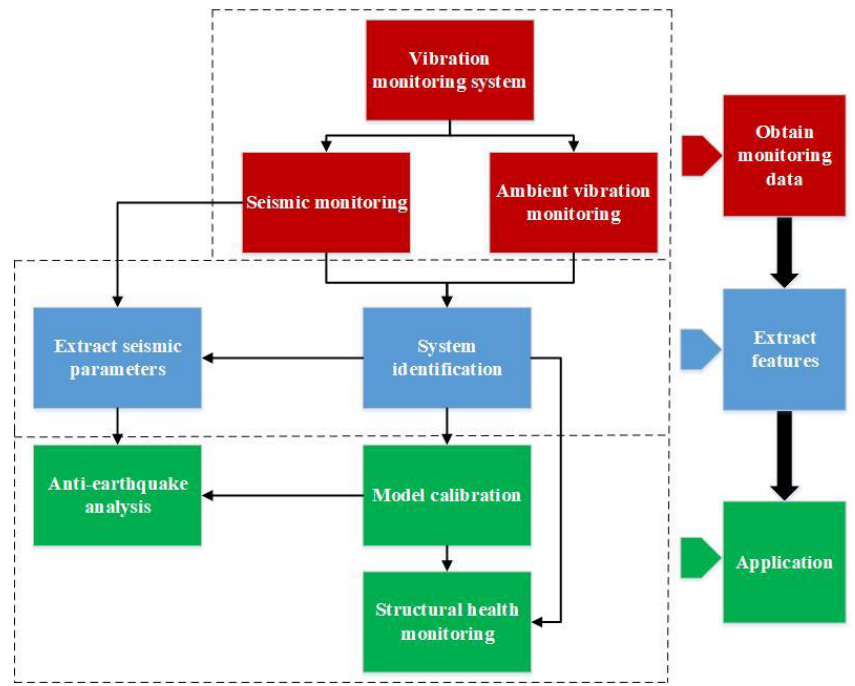
Figure 1. Application of the vibration monitoring data of concrete dams.